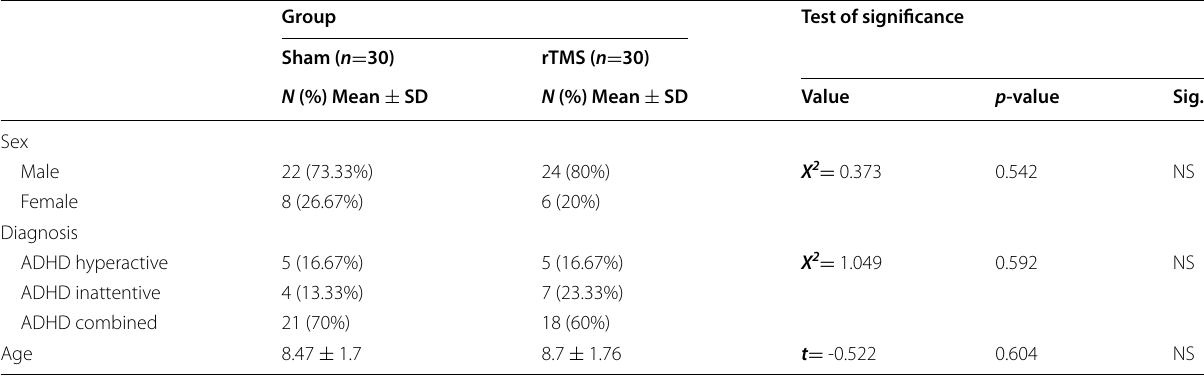
Table 1 Participant characteristics